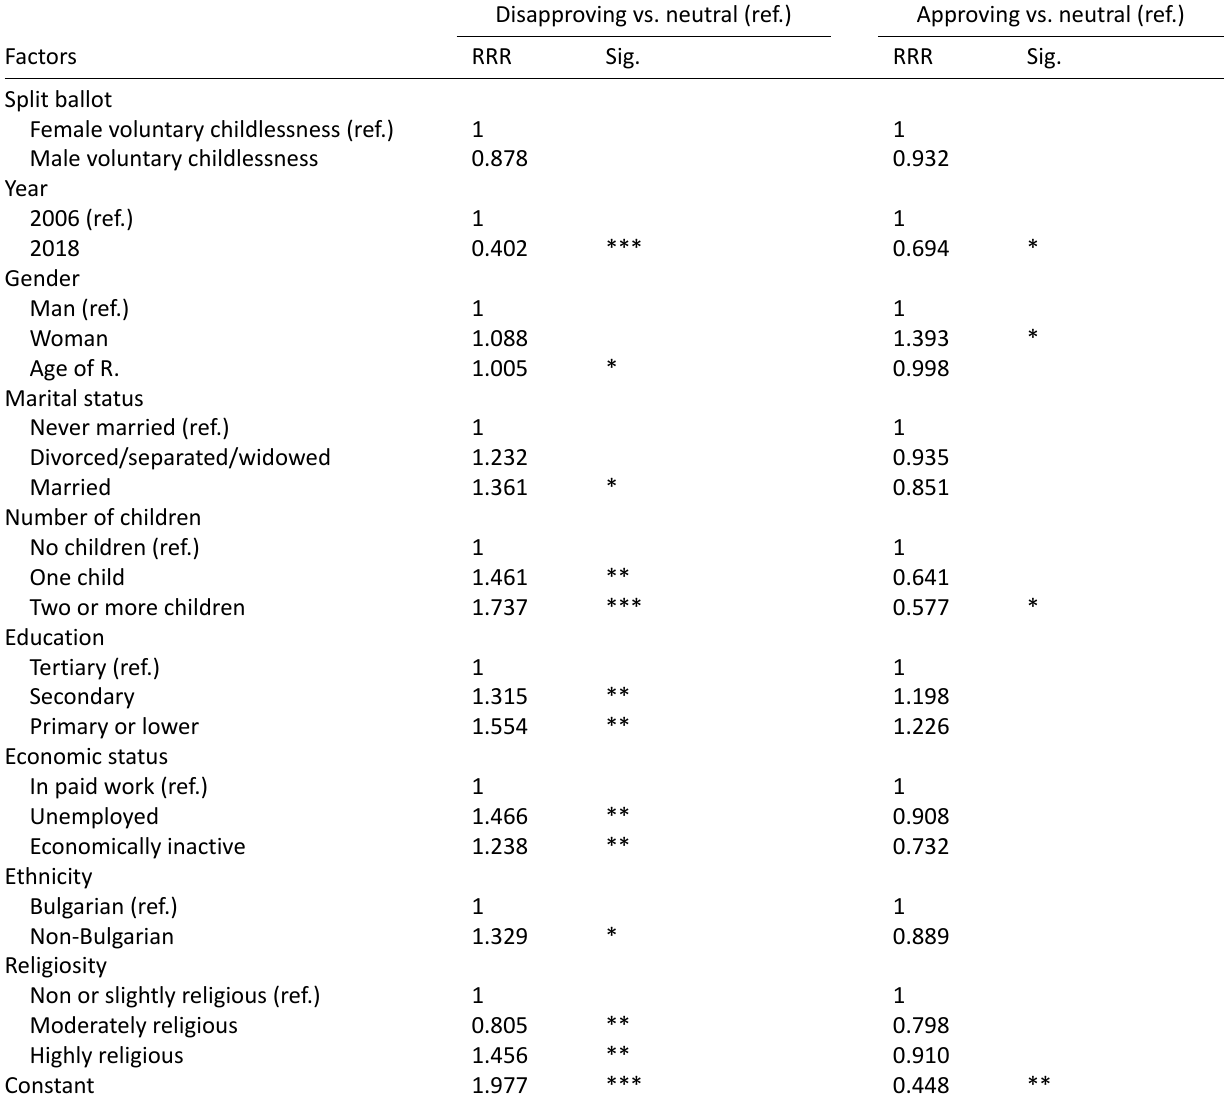
Table 1. Multinomial logistic regression of the attitudes toward voluntary childlessness in Bulgaria.